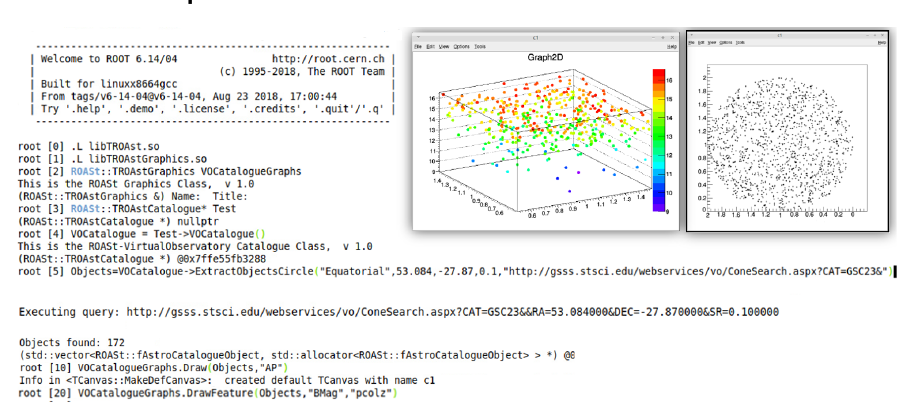
Figure 2: A ROAst use-case. Fig. 2 shows a use-case in which the user extracts a circular region from an on-line Virtual Observatory via the VOCatalogue::ExtractObjectCircle method. After the extraction, the space region is plotted using the Draw method and the second magnitude is plotted using the DrawFeature method. A C++11-compliant compiler is required, as well as ROOT 6 and the libcurl library, in order to use ROAst. A limited support is also available for